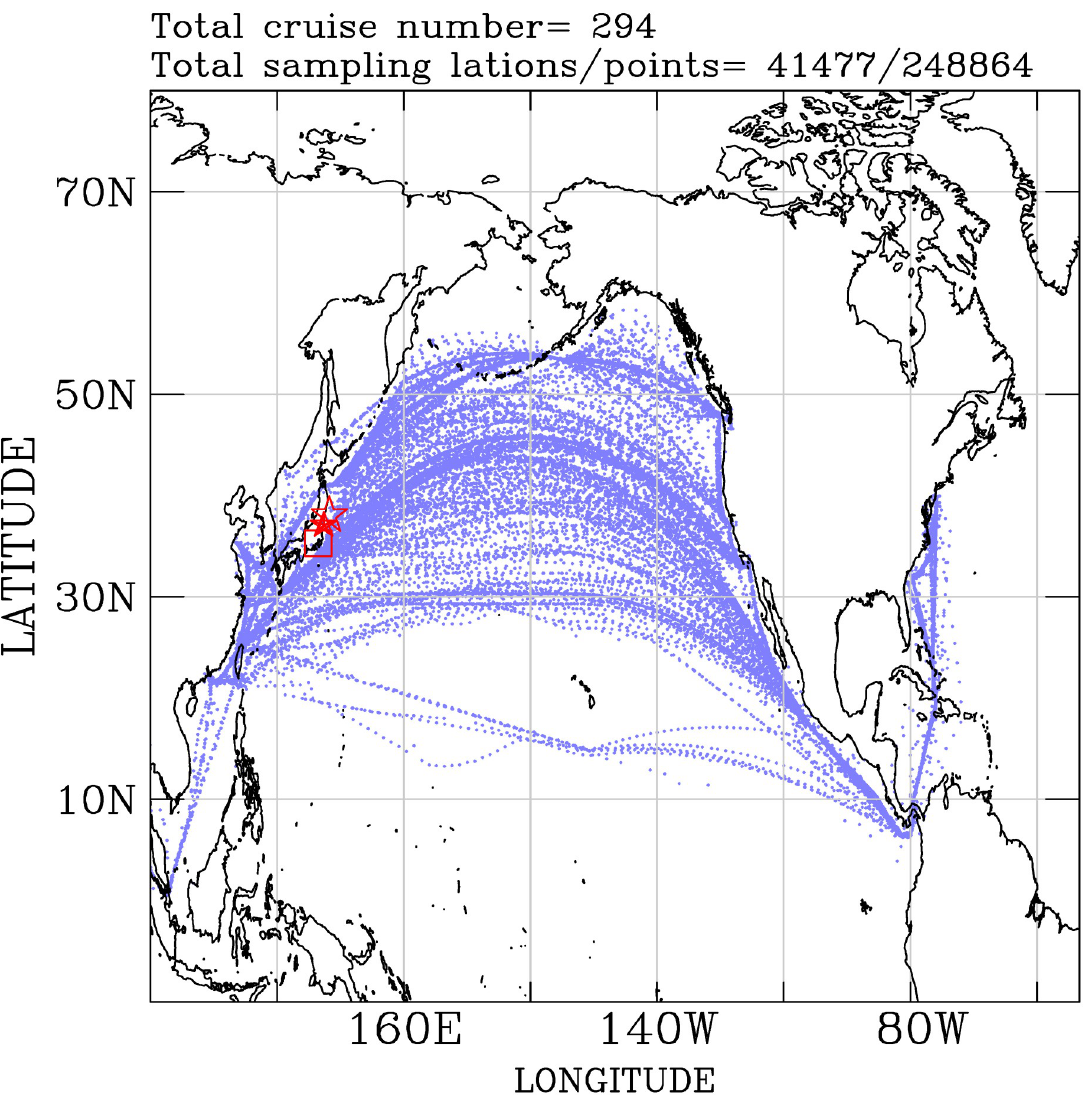
Fig 2. Measurements of the radioactivity dose rates over the North Pacific and the northwestern Atlantic marine atmosphere. The open star is the location of the 11-March-2011 earthquake epicenter, the solid star is the FDNPS site, and the open square is the Port of Tokyo office area. Map made with Natural Earth. Free vector and raster map data at naturalearthdata.com.